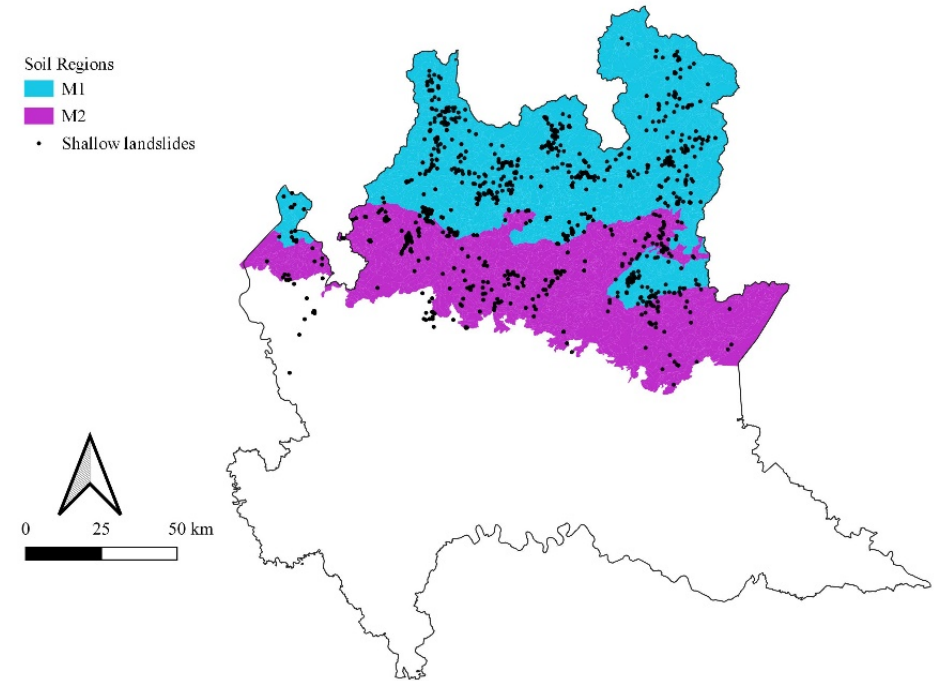
Figure 3. Soil regions included in the study area. Soil regions are based on soil classification by [87]): M1, Central Alps (SR 37.1); M2, Southern Alps (SR 34.3). Black dots represent the shallow